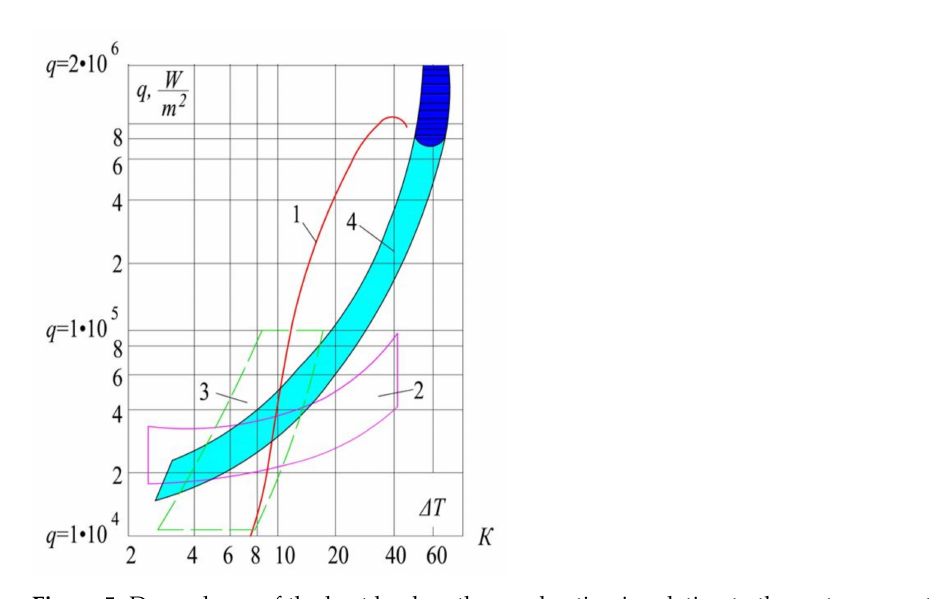
Figure 5. Dependence of the heat load on the overheating in relation to the water vapor tempera- ture (1–4): 1—large-volume boiling on an uncoated surface [17,25,27–31,35,37,38,41,42,44]; 2—heat pipes operational area [18,23,24,26,32–34,36,39,43,45] with mesh wicks; 3—thin-film evaporators operational area [10]; 4—capillary-porous cooling system investigated. Shaded area—application of intensifiers in the porous system [15,40].